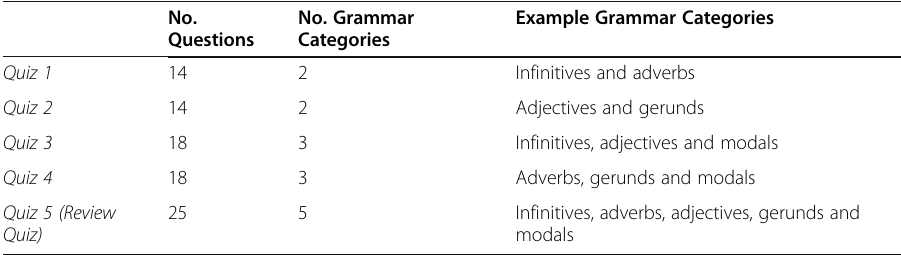
Table 1 A Typical Set of Grammar Tests in IGSS